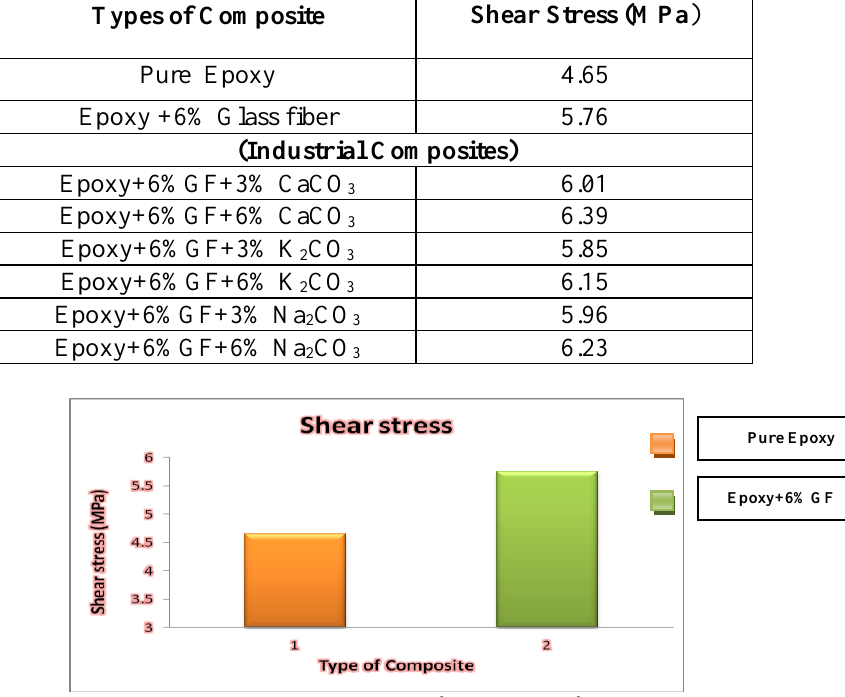
Fig.16: Shear stress of Epoxy +6% glass fiber composites and pure epoxy.